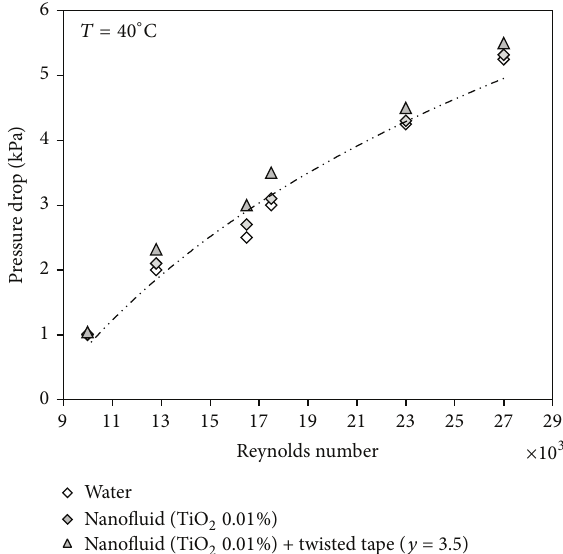
Figure 10: Comparison between measured friction factor and that calculated from Duangthongsuk and Wongwises correlation [9].